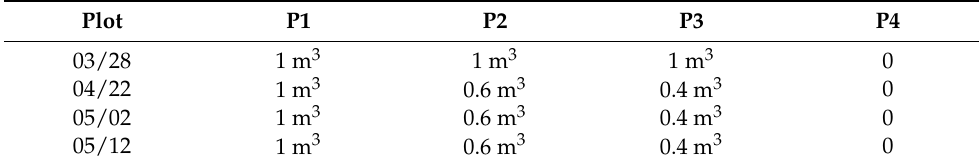
Table 1. Irrigation treatments for four plots.